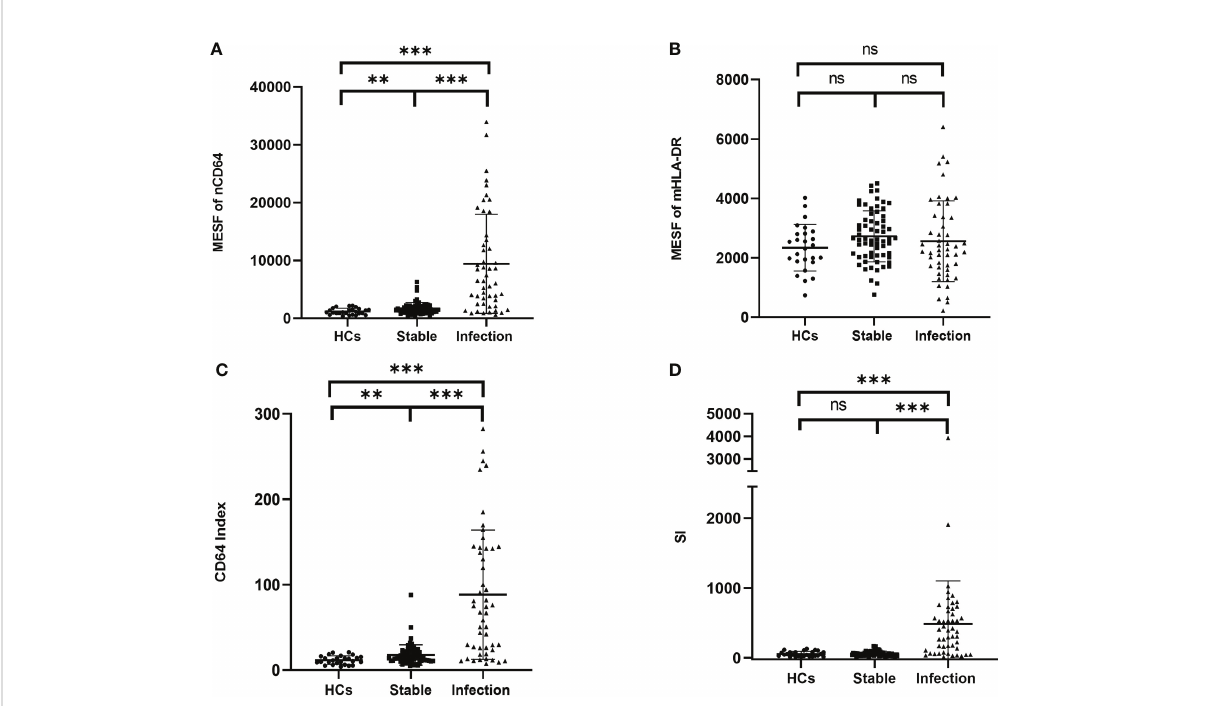
FIGURE 4 Comparison of the MESF of nCD64 (A) , MESF of mHLA-DR (B) , CD64 index (C) and SI (D) between HCs, stable KTRs and infection KTRs. Tested by the least signi fi cant difference test for back testing of multivariate ANOVA. *** means P < 0.001, and ** means P < 0.01. nCD64, neutrophil CD64; mHLA-DR, monocyte HLA-DR; HC, Healthy controls; KTRs, kidney transplant recipients; MESF, molecules of equivalent soluble fl uorochrome; SI, Sepsis index; MESF, molecules of equivalent soluble fl uorochrome. ns, no signi fi